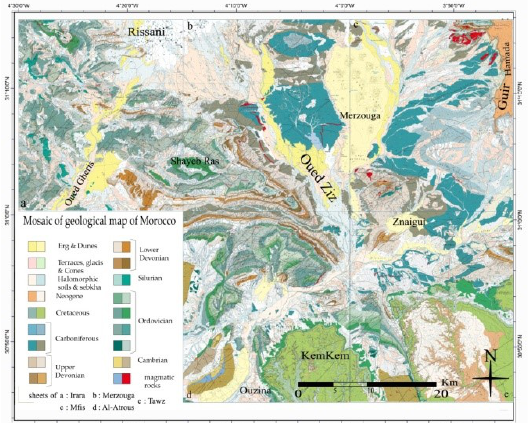
Figure4: Mosaic of geological map of Morocco at 1/50000°